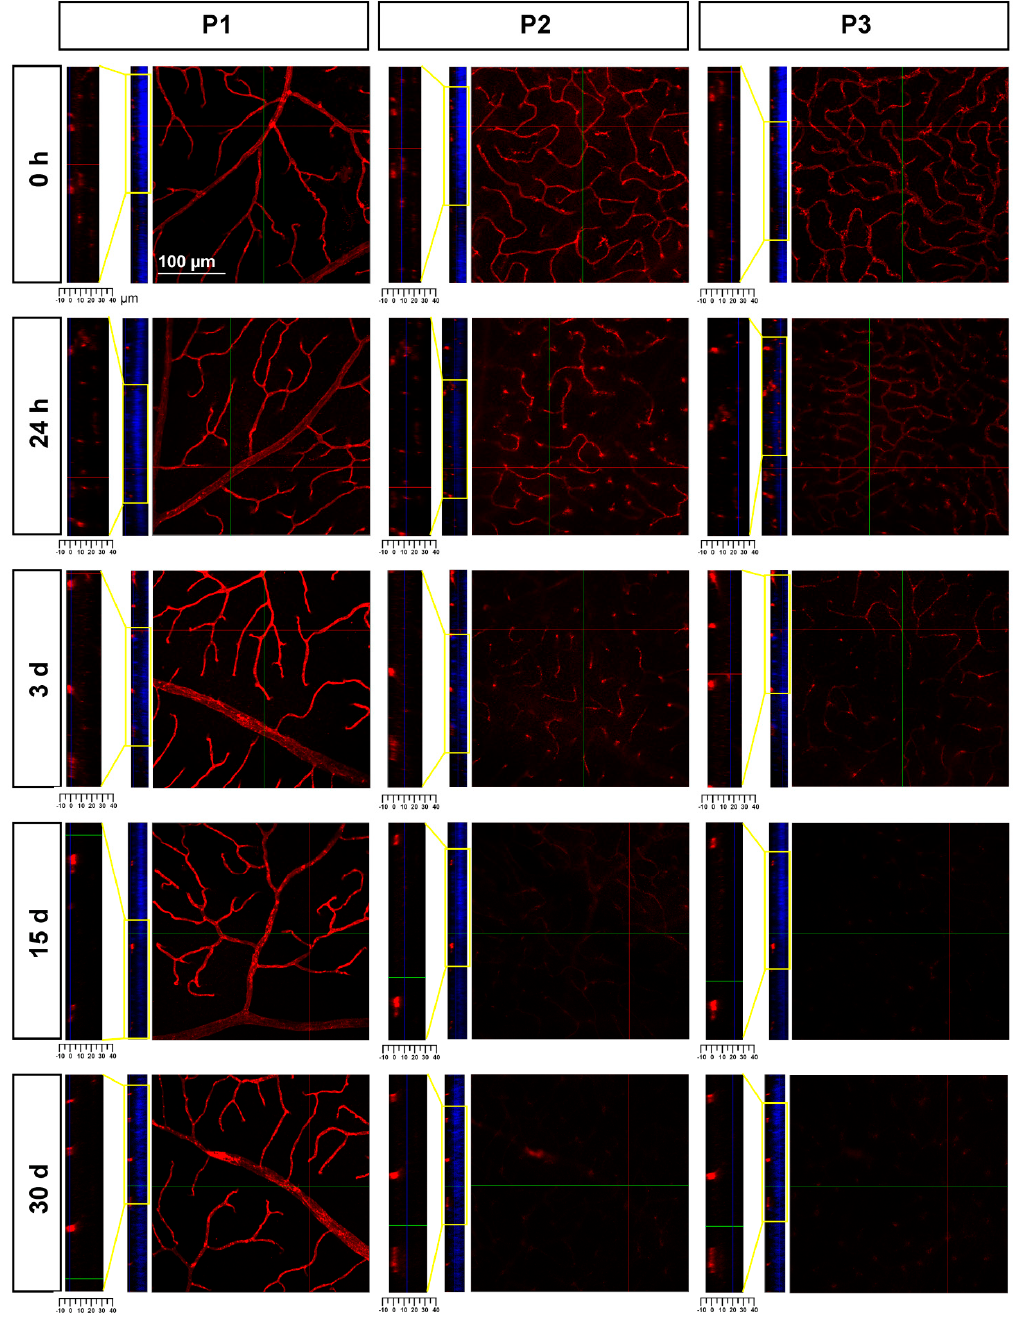
Figure 8. Loss of Ly6c expression in the intermediate and deep vascular plexuses of the contralateral uninjured retinas. Confocal images showing Ly6c signal in the three plexuses from 0 h to 30 days after the induction of the ischemia. To the left of each magnification is shown the z-stack spanning the retinal thickness (DAPI in blue) and a magnification of the z-stack (yellow square) where the ganglion cell layer is positioned a 0 µ m in all